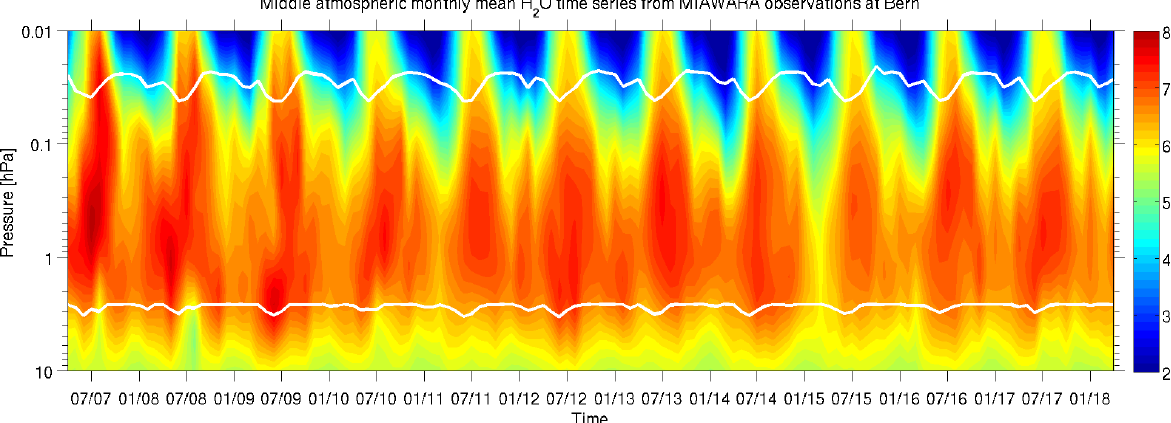
Figure 4. Monthly mean water vapor time series in parts per million (ppm) obtained by the MIAWARA instrument located at the Zimmerwald observatory near Bern between April 2007 and May 2018. The horizontal upper and lower white lines indicate the pressure layer within which the measurement response is higher than 80%. This data set is used as input for the trend model.